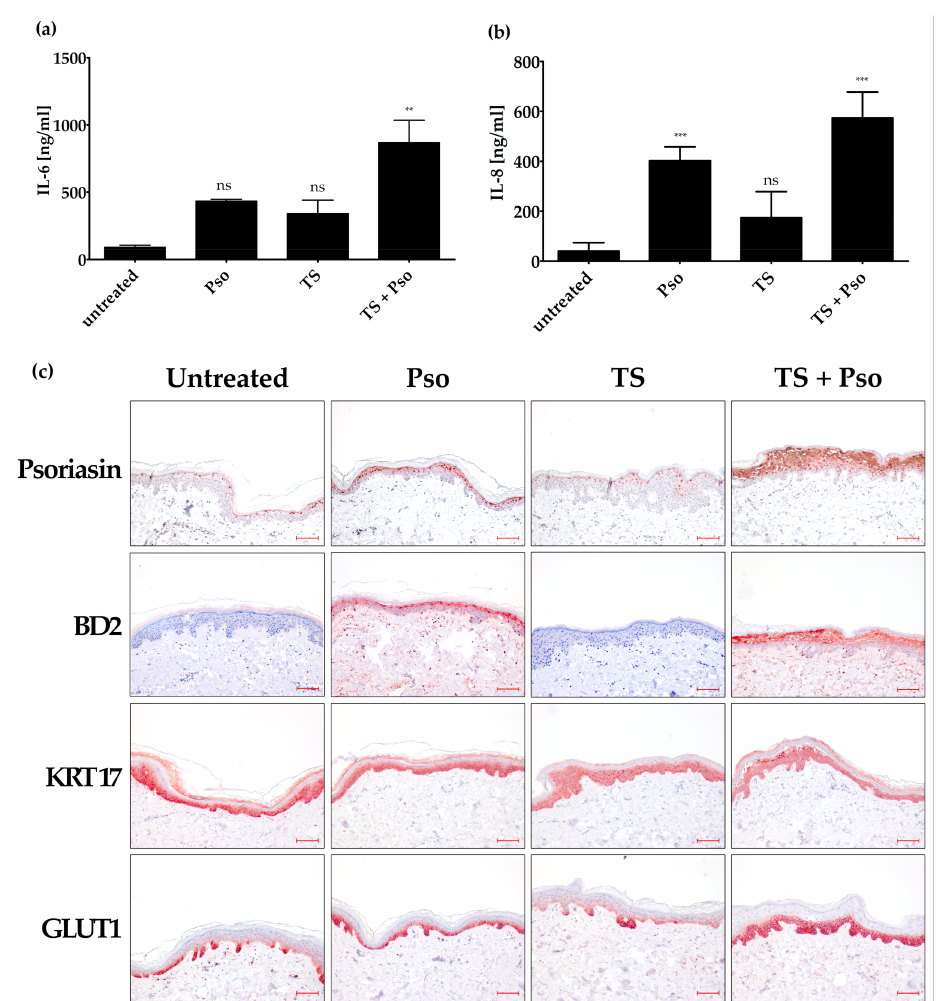
Figure 3. Generation of an ex vivo psoriasis model. Skin models have been cultured for 4 days at the air-liquid interface using appropriate differentiation medium. The skin models were left untreated, stimulated with psoriasis cytokines (IL-17A, TNF- α , IL-22, 20 ng/mL each; Pso), tape stripped (TS) or both actions were performed (TS + Pso). The protein level of secreted IL-6 ( a ) and IL-8 ( b ) was measured in the cell culture supernatant by ELISA ( n = 4). ( c ) Skin models were fixed, embedded in paraffin and 3 µ m sections were stained with antibodies against psoriasin (S100A7), β -defensin 2 (BD2), keratin 17 (KRT17) or glucose transporter 1 (GLUT 1) ( n = 4). Scale bar = 100 µ m. ** p ≤ 0.01, *** p ≤ 0.001, ns-not significant ( p >